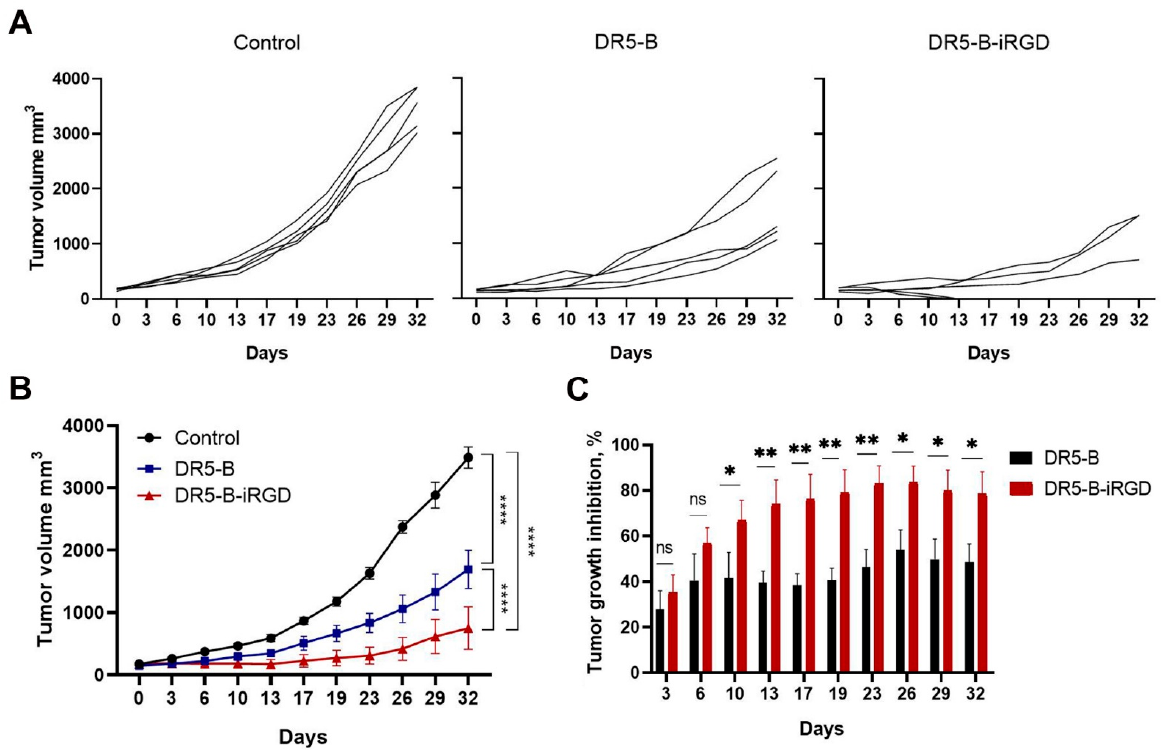
Figure 6. Comparison of DR5-B and DR5-B-iRGD antitumor activity in vivo. U-87 human glioblas- toma xenograft tumors were established in Balb/c nu/nu mice by subcutaneous injection of 1 × 10 7 cells. When tumor volume reached 0.163 ± 0.032 cm 3 , mice were treated by intravenous injection of 10 mg/kg/d of preparations (seven times every two days). Arrows show the scheme of drug administration. ( A ) Tumor growth curves for individual mice in each treatment group ( n = 5). ( B ) Tumor volumes were determined every 3–4 days by percutaneous measurement with caliper. Tumor volumes presented as mm 3 ± SEM ( n = 5). **** ( p < 0.0001) indicates significant difference between data groups according to two-way ANOVA test. ( C ) Values of tumor growth inhibition were calculated by the formula [(Vc − Vex)/Vc] × 100%, where Vex and Vc are the tumor volumes in experimental and control groups ( n = 5). * ( p < 0.05) and ** ( p < 0.005) indicate significant difference according to Student’s